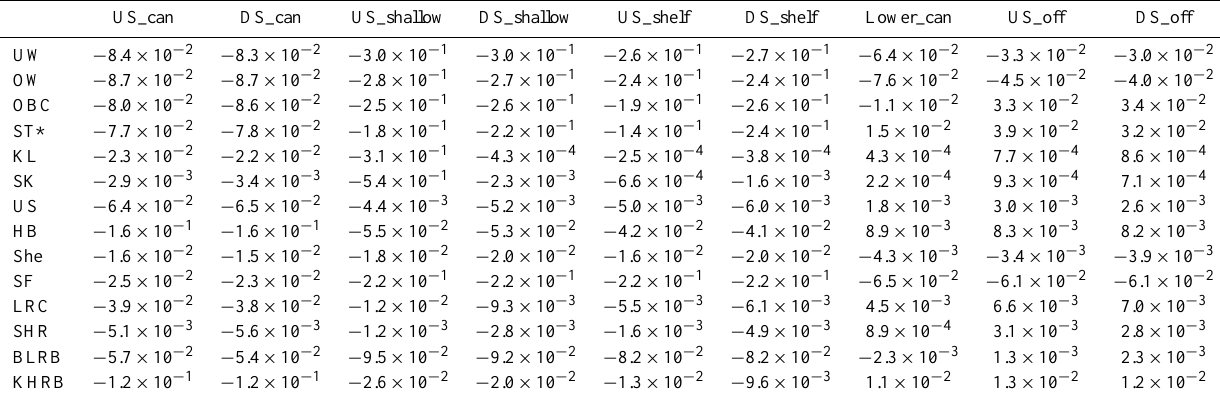
Table 9. Average density anomalies across nine regions for all model simulations. Values are averaged during the advection-dominated phase (model days